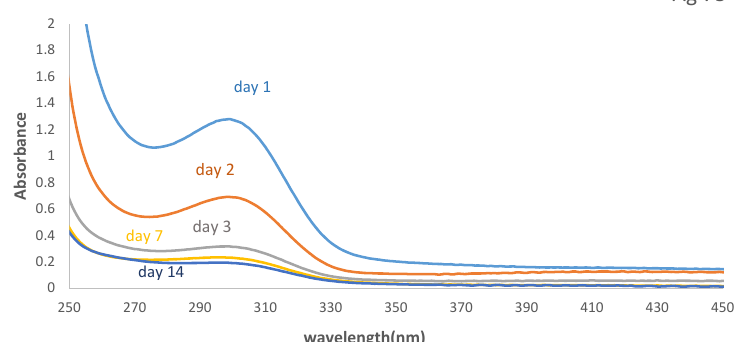
Fig. 2: The absorption spectrum of silver nanoparticles synthesized by electrochemical method at 75 seconds interval in the first, second, third, seventh and 14 th days (1 amp current and rotation speed of 3000 RPM).